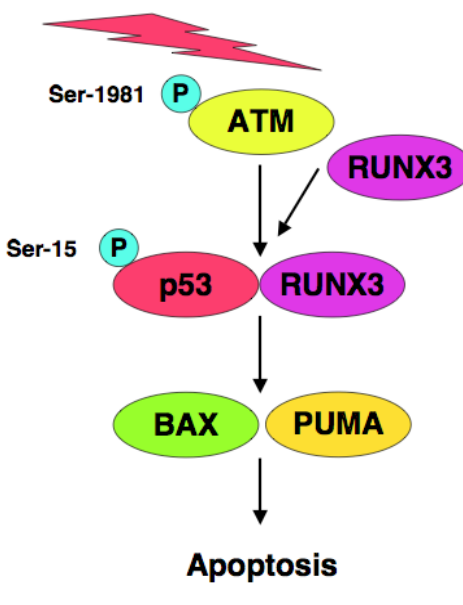
Figure 2. Functional interaction between p53 and RUNX3. Upon DNA damage, RUNX3 is associated with phosphorylated form of ATM (p-ATM) and recruits it to p53 to facilitate phosphorylation of p53 at